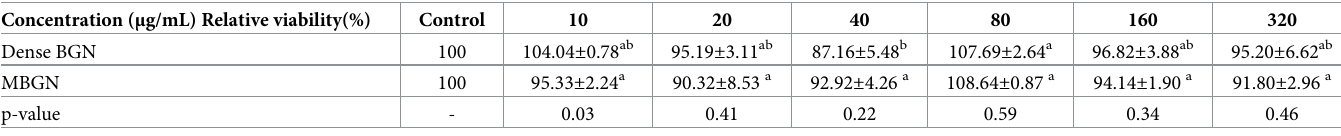
Same superscript lowercase letter within rows indicates no significant difference (p >